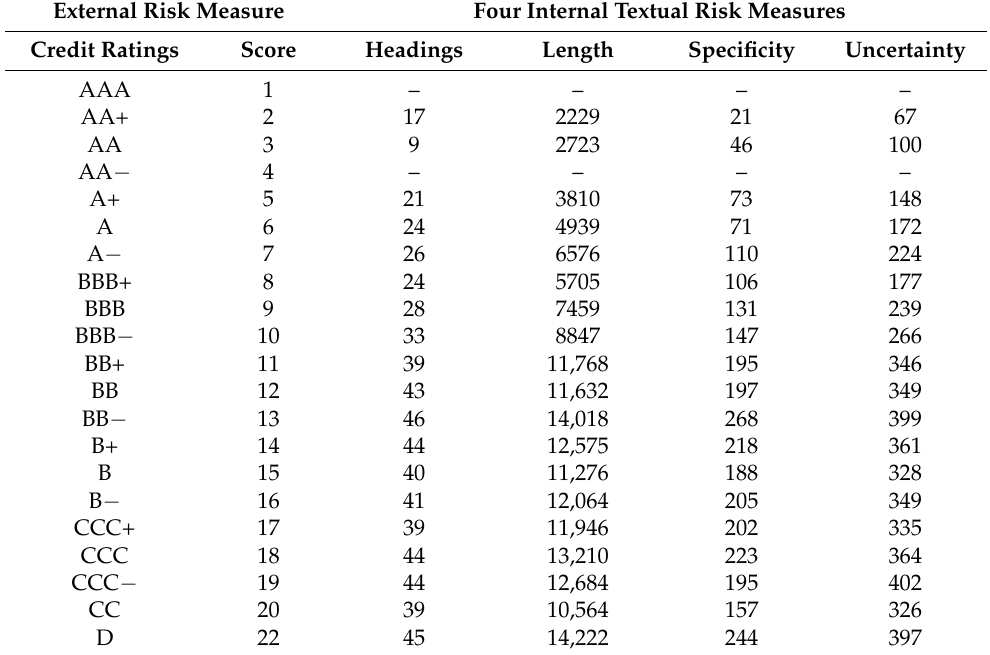
Table 2. Four internal textual risk measures’ mean values located at each credit